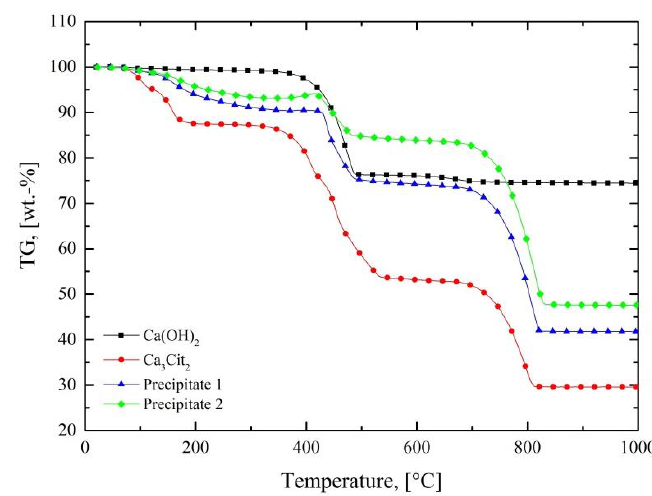
Figure 3. Thermogravimetric analyses in air of pure Ca(OH) 2 and Ca 3 Cit 2 , as well as two precipitates from the aforementioned preliminary investigations, in which Ca(OH) 2 served as the precipitating agent.